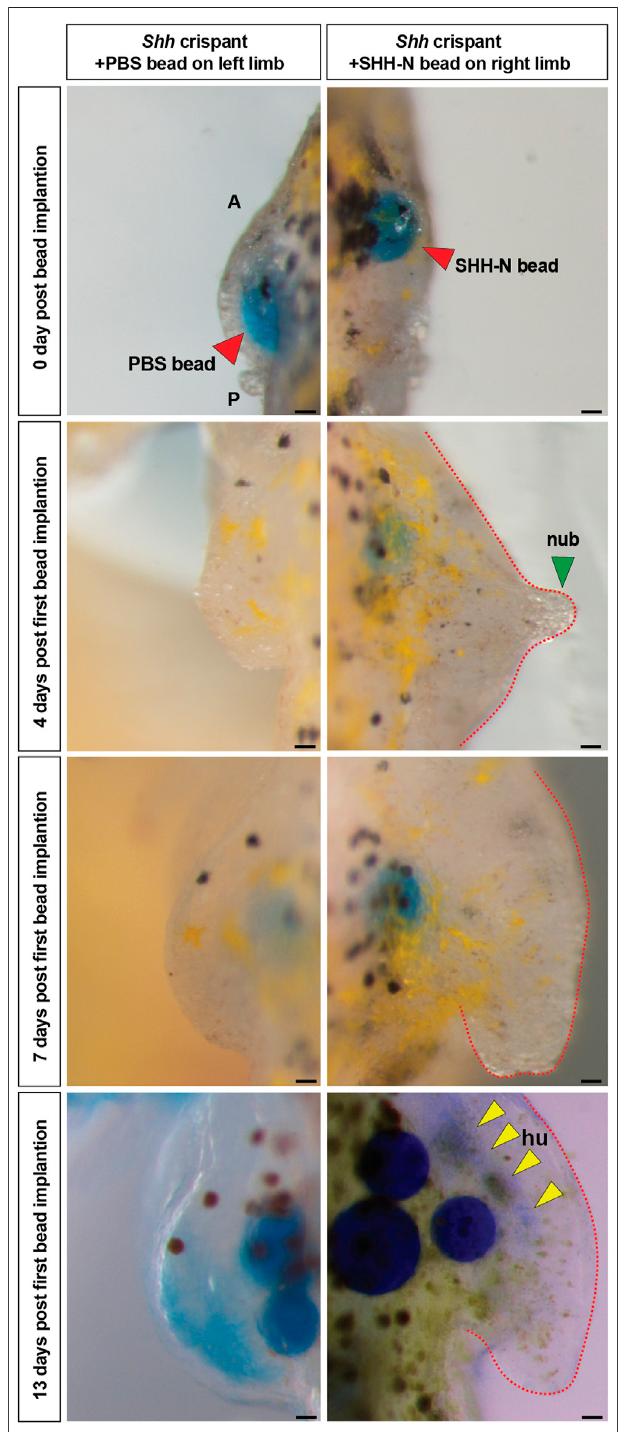
FIGURE4| ExogenousSHH-Nproteinstimulatesforelimbdevelopment from Shh crispantforelimbprogenitors.Limbrescueexperimentsusingbeads loaded with SHH-N protein. Control Af fi -Gel blue beads (red arrow) soaked in 1× PBS with 0.1% BSA and Af fi -Gel blue beads (red arrow) soaked in SHH-N protein (0.5 or 0.25 µg/µl) in 1× PBS with 0.1% BSA were grafted into the leftand right limb fi elds,respectively, of Shh crispants. Yellow arrows, faint